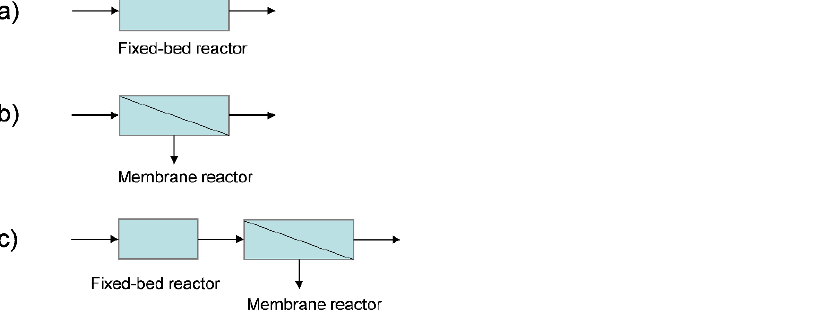
Figure 9. Different reactor configurations used for MDA. ( a ) Fixed-bed reactor; ( b ) membrane reactor; ( c ) integration of a fixed-bed reactor and a membrane reactor.